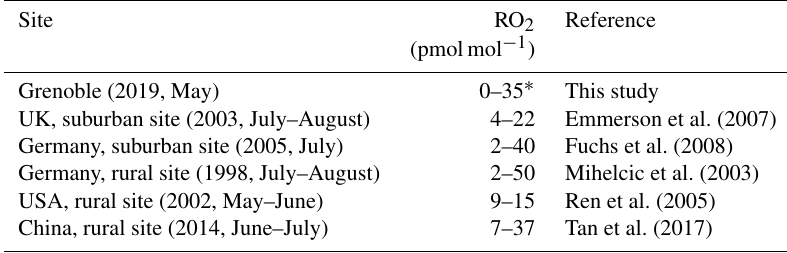
Table 2. Mean daytime RO 2 mixing ratio ranges measured during field campaigns in various environments and